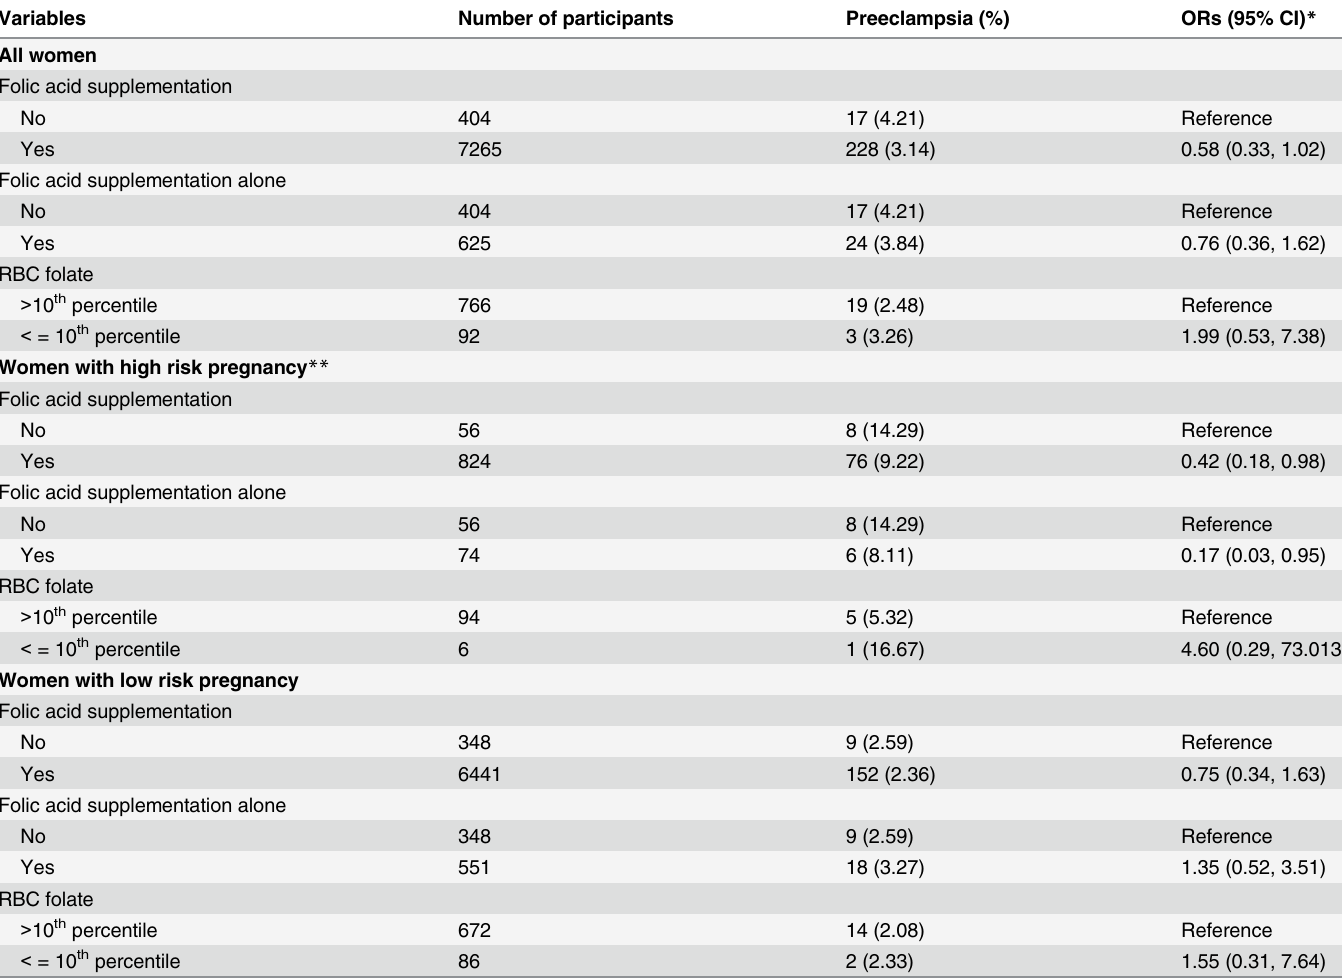
Table 4. Adjusted odds ratio (OR) and 95% confidence interval (95%CI) of